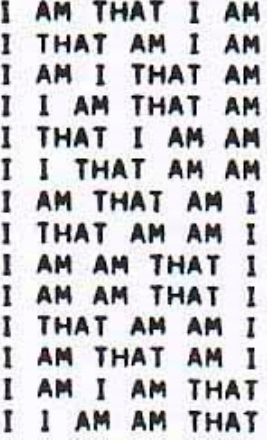
Figure 3. Brion Gysin. Permutation poem 1960 ([7], p. 93).